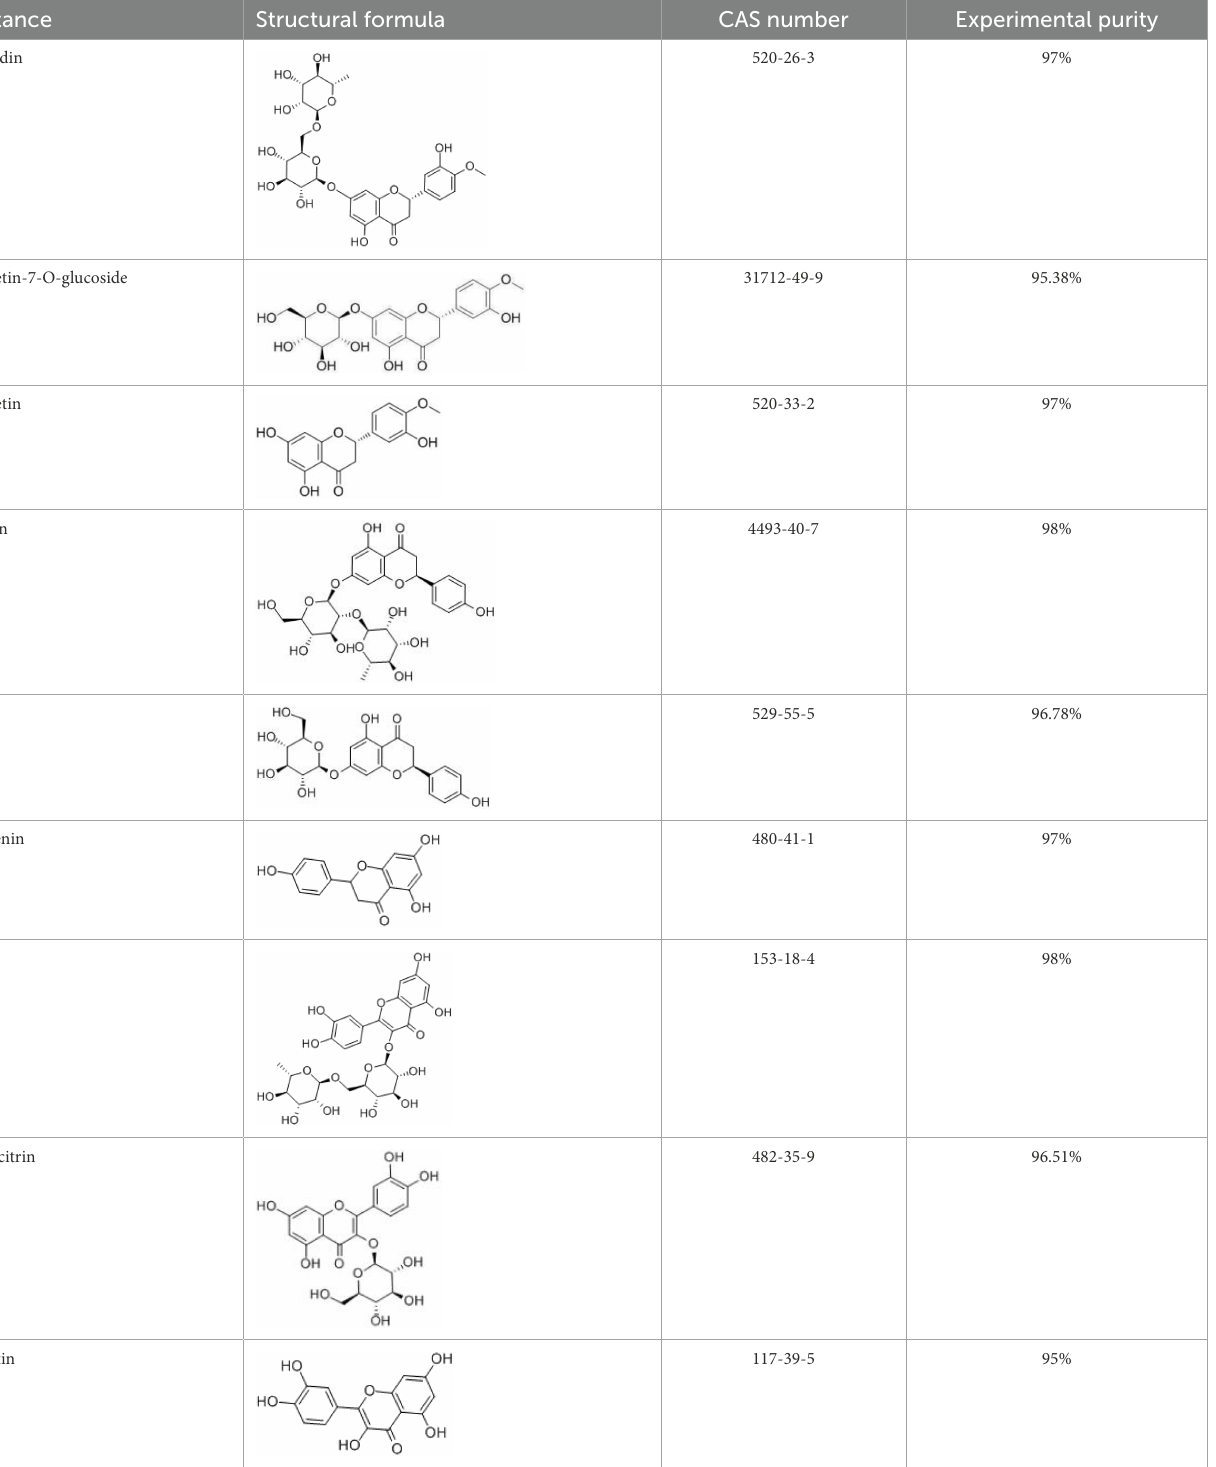
TABLE 1 Structural formulae and related information of the nine